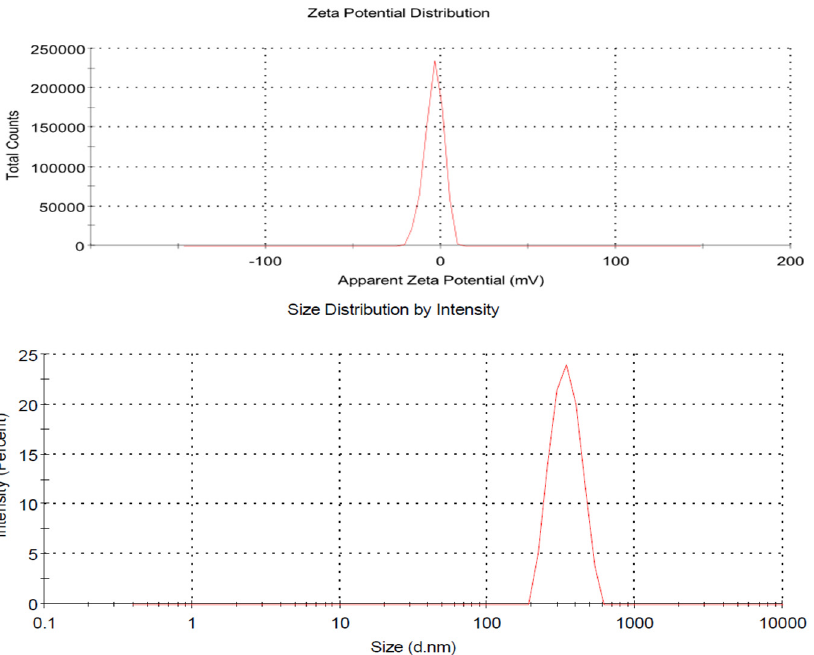
Figure 1. Average particle size distribution and zeta potential graphs of optimized